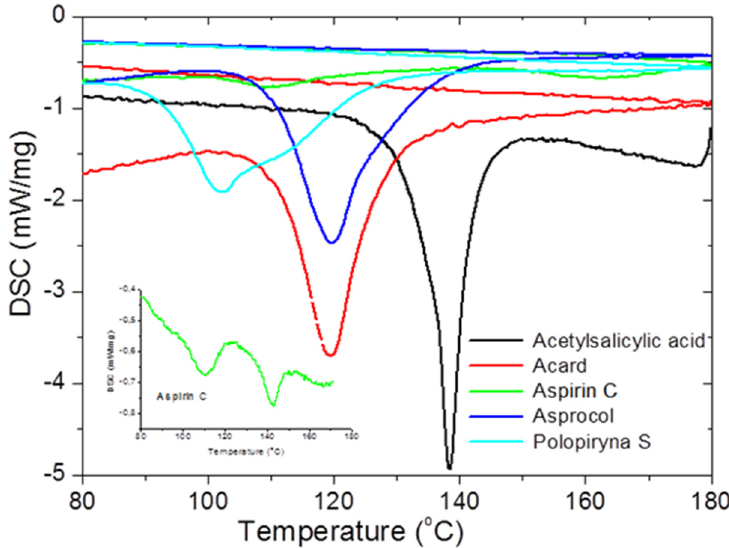
Figure 13. DSC curves for drugs containing acetylsalicylic acid.